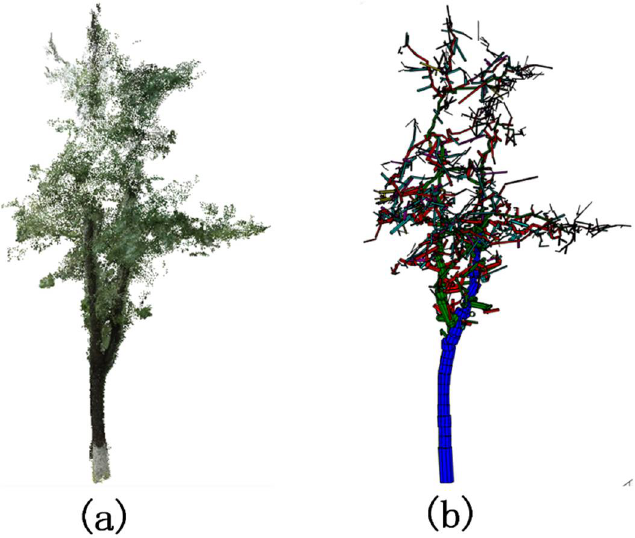
Figure 10. The tree model reconstructed by TreeQSM. ( a ) TP point clouds of trees, ( b ) reconstructed cylinder model.